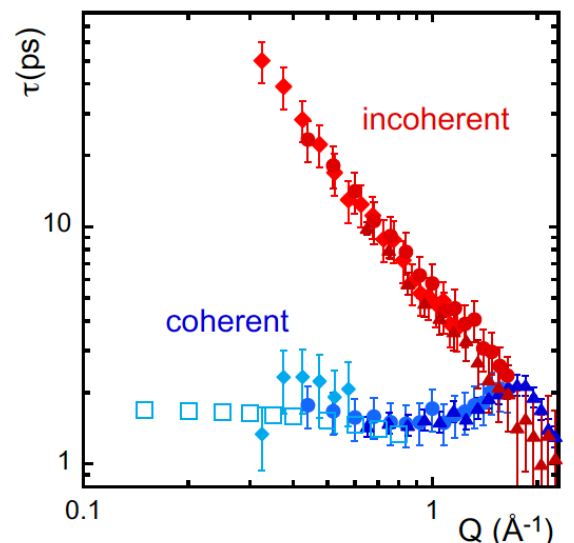
Fig. 1. Characteristic relaxation times (blue symbols: coherent; red symbols: incoherent) obtained by the procedure described in the text from the neutron scattering data with polarization analysis corresponding to a D 0 O sample at 300 K [15]. Different solid symbols correspond to data obtained with different incident neutron wavelengths. Open blue squares correspond to the coherent relaxation times obtained from the MD-simulations described in the